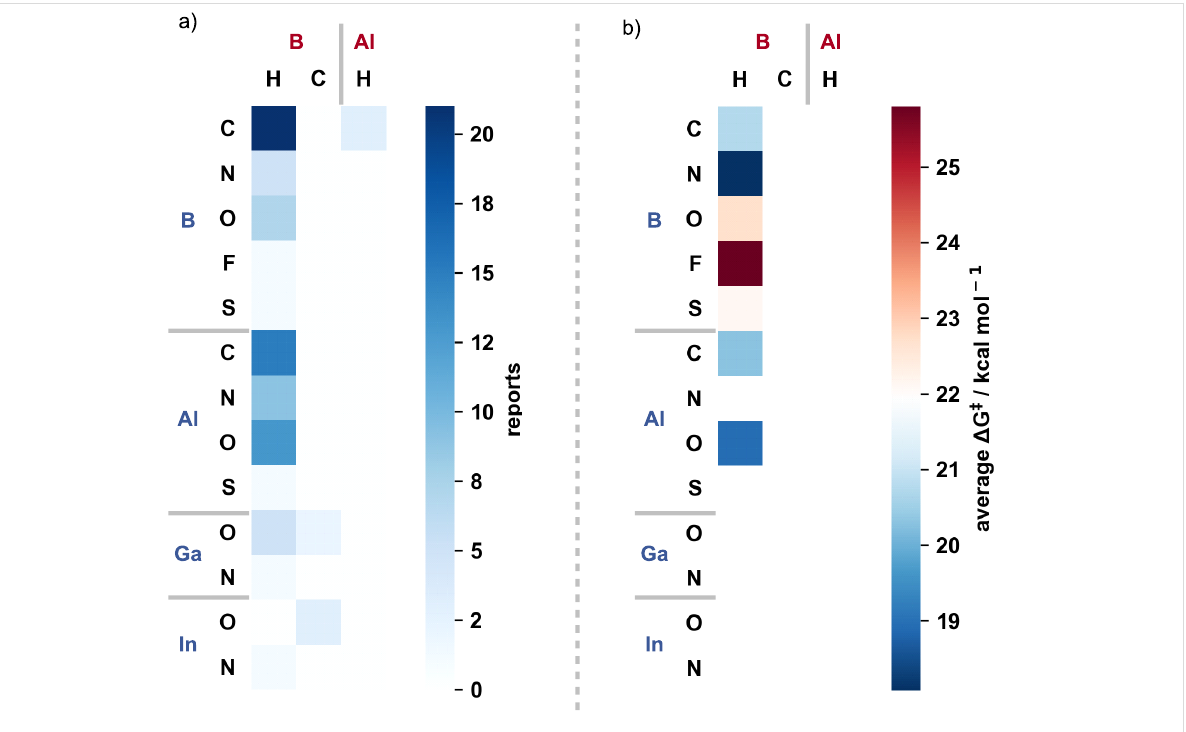
Figure 1: a) The number of reports for a given group 13 exchange in catalysis. b) Average free energy barrier to group 13 exchange in catalysis (blank where no free energy value was